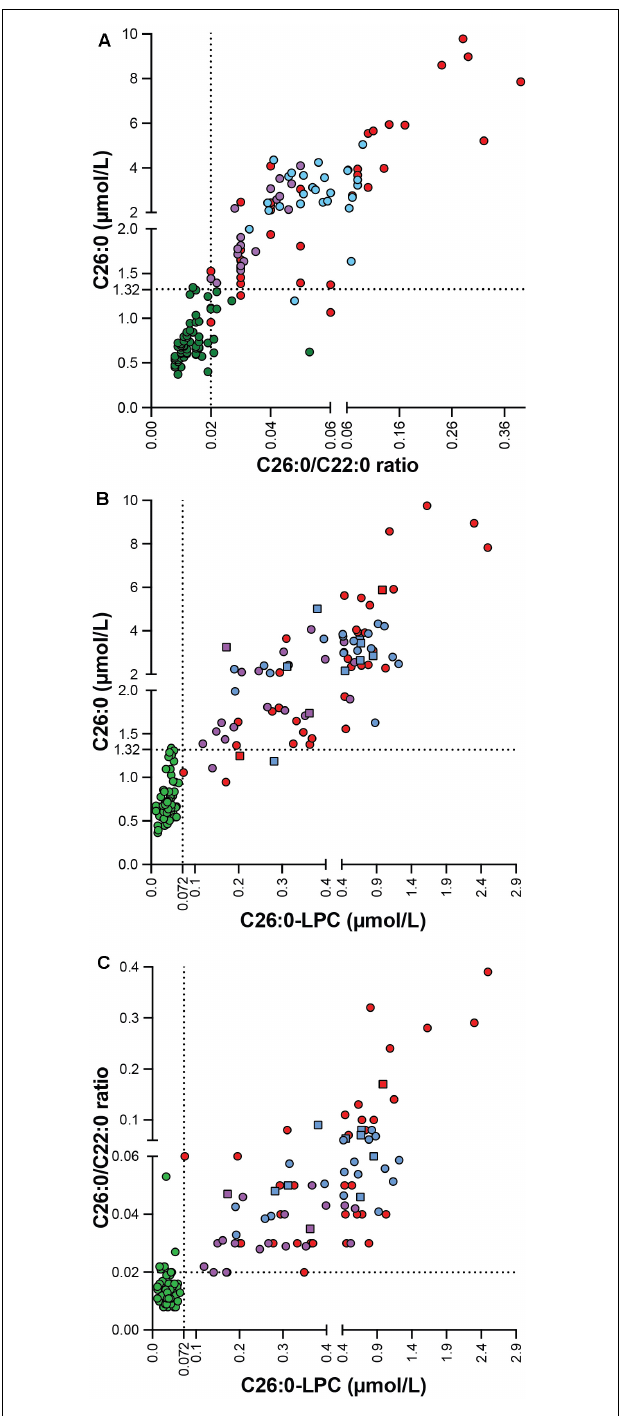
FIGURE 3 | Correlation plot showing the correlation between C26:0 concentration and the C26:0/C22:0 ratio (A) , C26:0-LPC and C26:0 levels (B) and C26:0-LPC level and the C26:0/C22:0 ratio (C) in controls (green, n = 67), ALD males (blue, n = 26), ALD females (purple, n = 19) and ZSD patients (red, n = 35). C26:0-lysoPC results from DBS are indicated by squares and plasma by circles. The upper limit of the reference range for C26:0 (1.32 µ mol/L), the C26:0/C22:0 ratio (0.02) and C26:0-LPC (0.072 µ mol/L) is indicated by the dashed